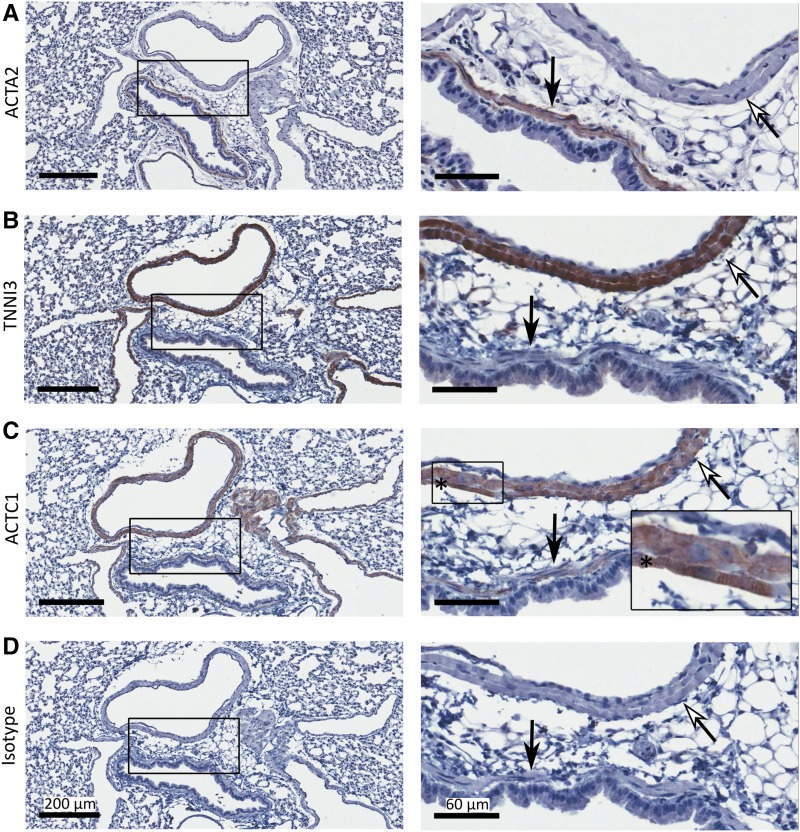
TNNI3 and ACTA2 are localized to different structures in mouse lung. Serial sections of lung tissue were immunostained for (A) ACTA2, (B) TNNI3, (C) ACTC1, and (D) IgG isotype control (Isotype). Images in right-hand panels (bar, 60 μm) show detail from black boxes in left-hand panels (bar, 200 μm). Distinct cell-type localization of TNNI3 in striated muscle (white ←) and ACTA2 in smooth muscle (black ←) are indicated. Muscle striations are shown in (C) (*).